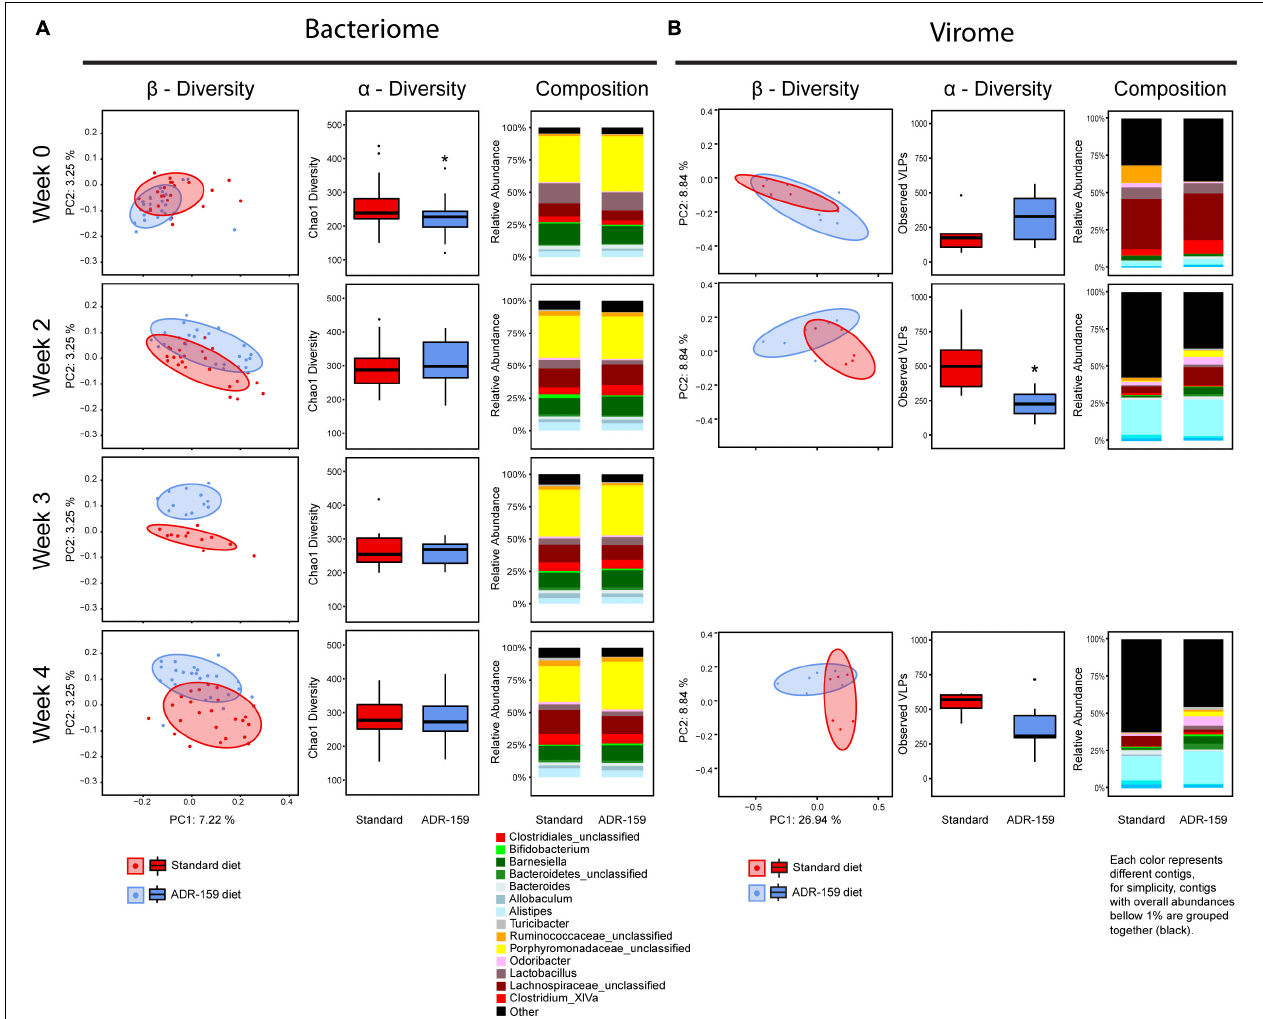
FIGURE 2 | Microbiome analysis before (week 0) and during (weeks 2, 3, and 4) the diet intervention with standard (red) and ADR-159 (blue) diet. (A) Bacteriome. 24 animals are represented per group at weeks 0, 2, and 4, while only 12 animals per group in week 3. Left: PCoA plots of microbiome composition using Jaccard distances. Each dot represents individual animal at each given time point. Ellipses represent the confidence interval of every group at 75%. Middle: Chao1 index, * indicates significant difference. Right: mean abundance at genus level. For simplicity, genera with abundances below 1% were grouped together. (B) Virome. Each group represents 6 cages, each of 4 animals. Left: PCoA plots of virome composition using the Spearman distances. Each dot represents a cage with 4 individual animals at each given time point. Ellipses represent the confidence interval of every group at 75%. Middle: observed number of viral contigs, * indicates significant difference. Right: mean abundance of viral contigs. Each color represents different contig, for simplicity, contigs with overall abundances below 1% were grouped together